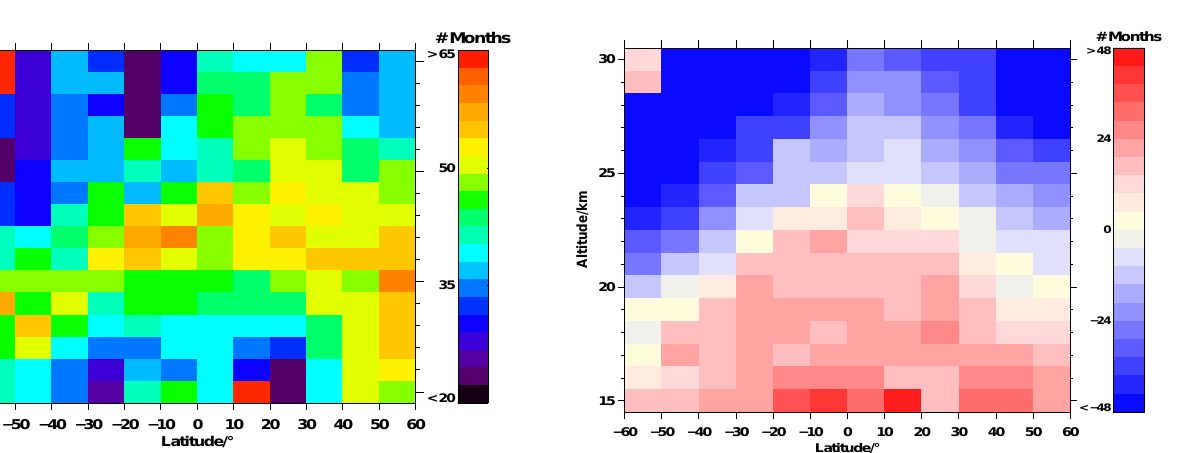
Figure 10. Inherent time lag of the solar signal in water vapour, i.e. difference of the phase shift of the solar signal in water vapour and the age of stratospheric air as derived in Stiller et al. (2012b). Positive values represent delays of the solar signal in water vapour larger than the stratospheric mean age of